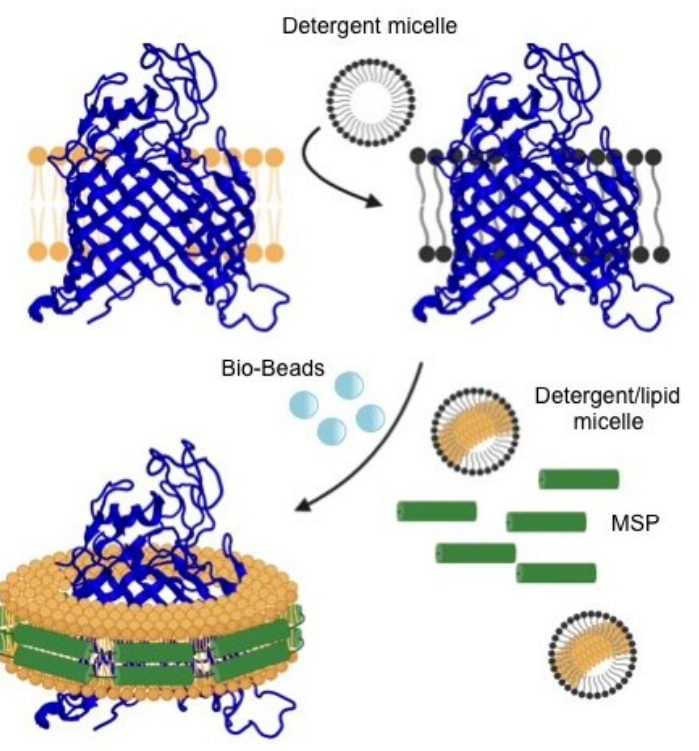
Figure 2. Membrane protein incorporation into a nanodisc. Detergent (black micelle)-solubilized membrane protein (blue) is incubated with a mixture of membrane scaffold protein (MSP; green) and detergent-solubilized lipids (tan). Nanodisc assembly is initiated after detergent removal. Table 1. Membrane scaffold proteins. A summary of the most used MSPs in nanodisc formation including final nanodisc diameter, molecular mass, and particular features associated with each MSP is